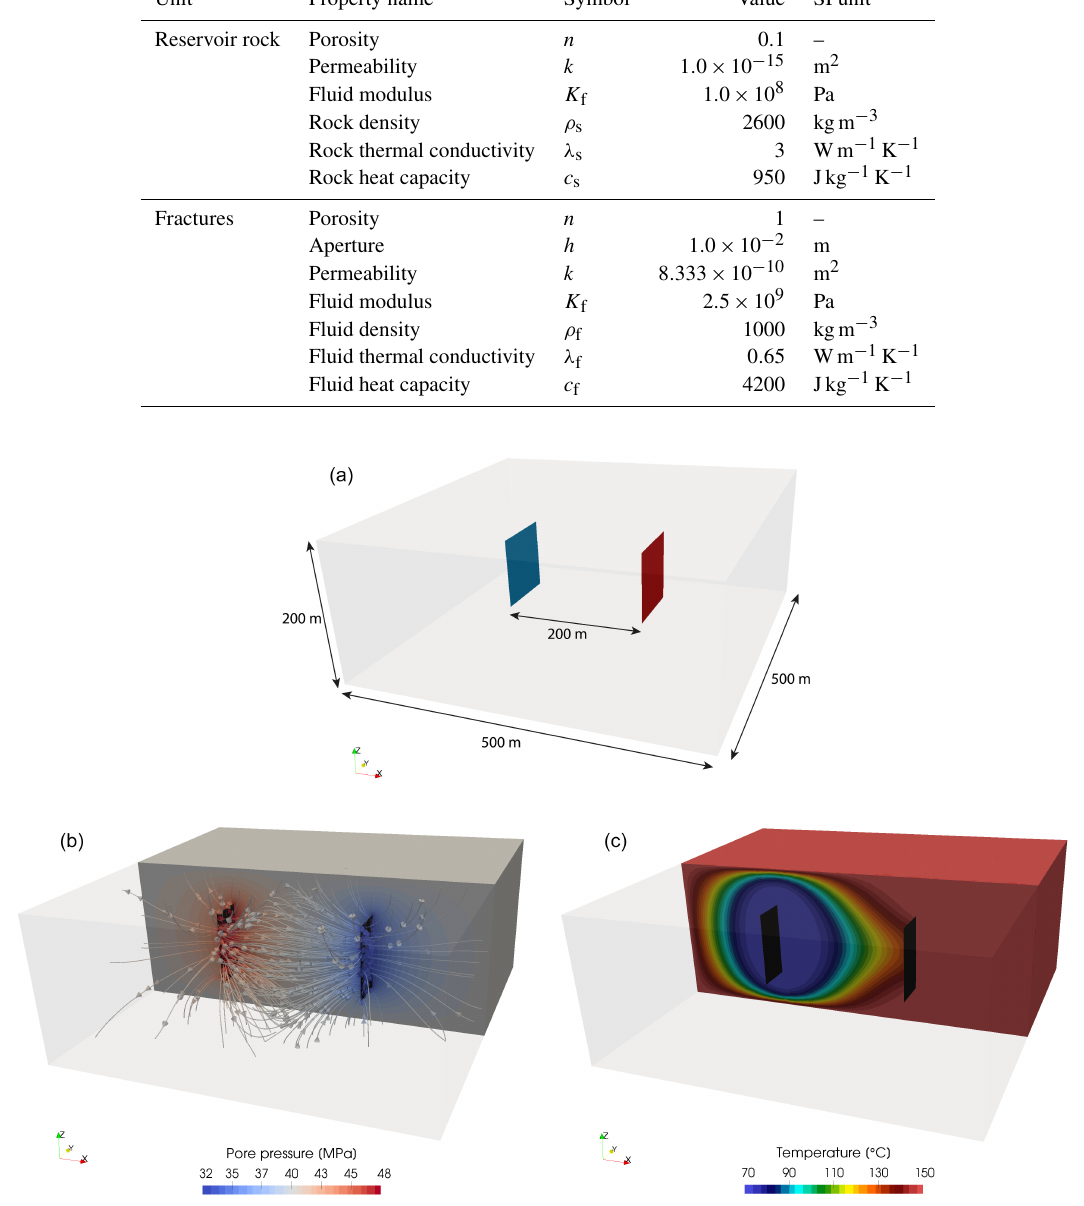
Table 5. Material properties for the thermo-poroelastic response of a geothermal doublet.